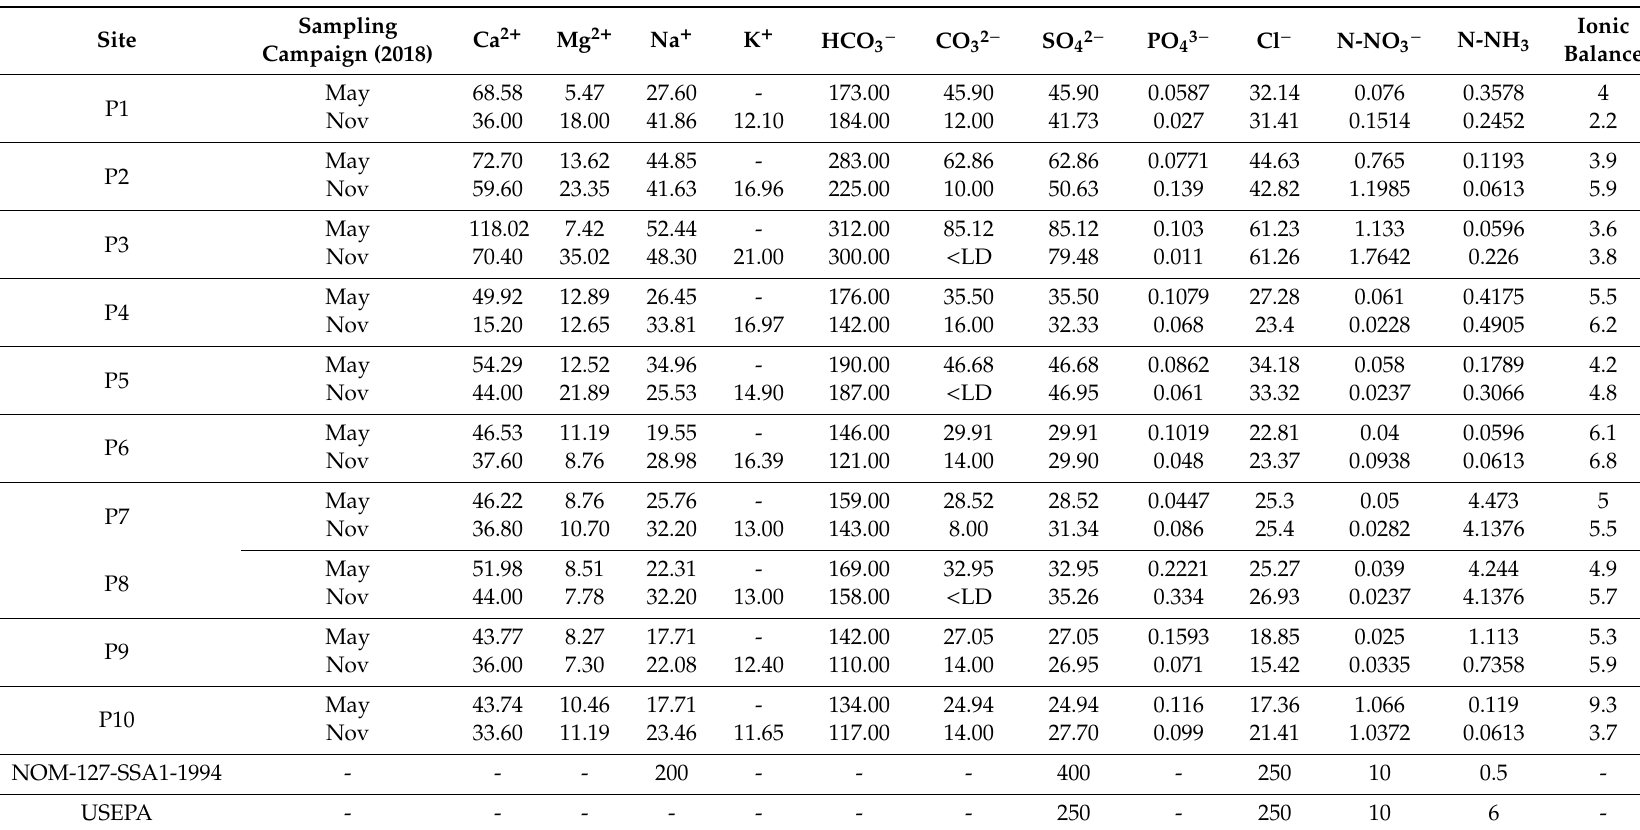
Table 8. Major ions in the water samples from the 10 sites expressed in mg / L: calcium (Ca 2 + ), magnesium (Mg 2 + ), sodium (Na + ), potassium (K + ), acid carbonate (HCO 3 − ), carbonate (CO 32 − ), sulfate (SO 42 − ), phosphate (PO 43 − ), chloride (Cl − ), nitrate (N-NO 3 − ), ammoniacal nitrogen (N-NH 3 ), and the ionic balance